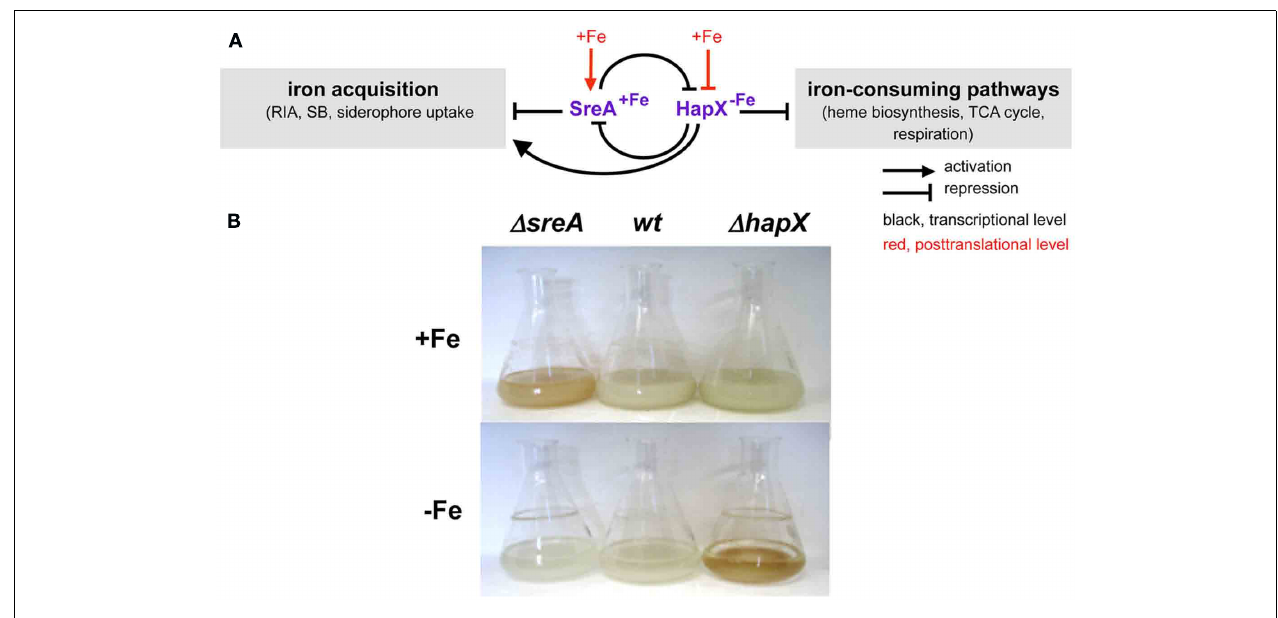
reddish colored during iron starvation due to accumulation of protoporphyrin IX, while Δ sreA mycelia are reddish colored during iron sufficiency due to accumulation of iron, heme, and FC (Schrettl et al., 2008,